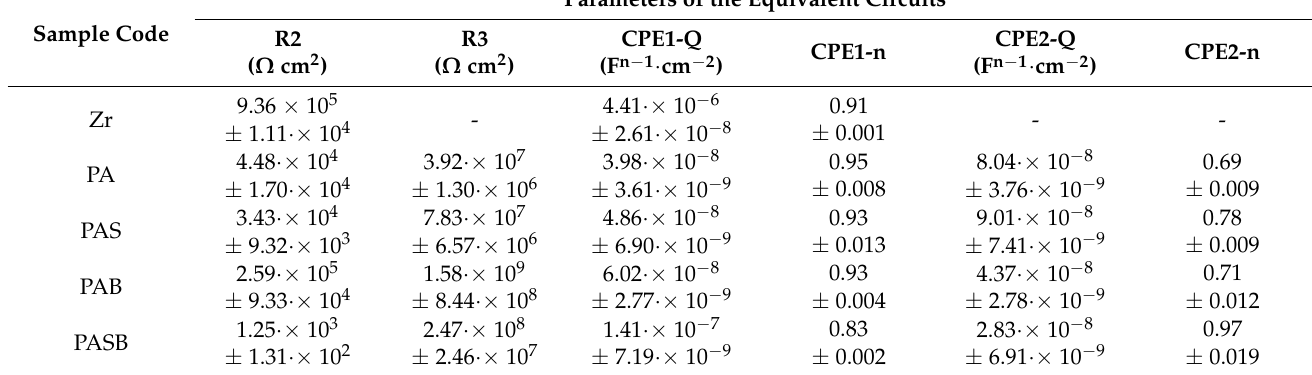
Table 9. EIS fit results of the parameters of the equivalent circuits for the uncoated and PEO-coated samples tested in Ringer’s solution.